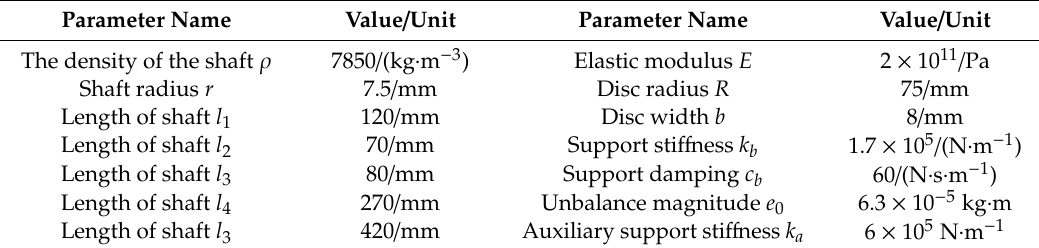
Figure 3. Dynamic model of three-support shafting with double disks. Table 1. Basic parameters of three-support shafting.